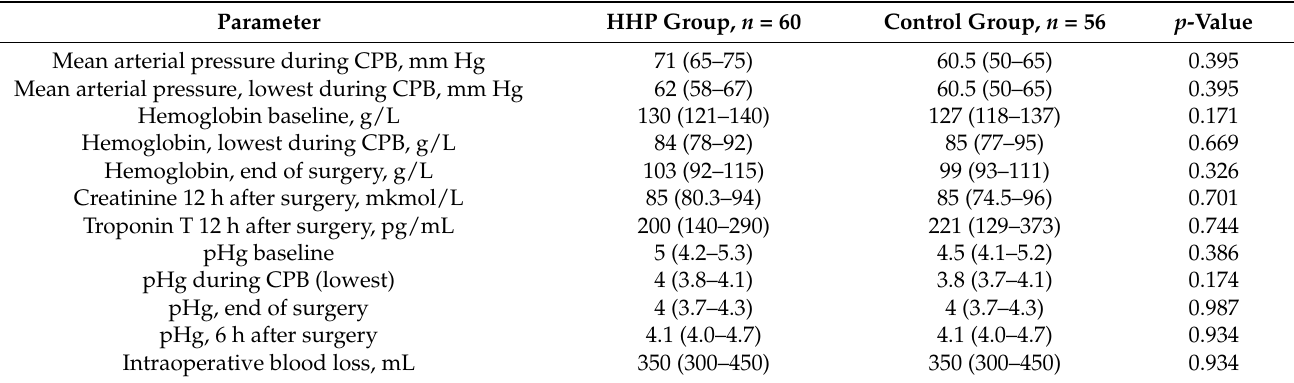
Table 2. Dynamics of perioperative parameters.